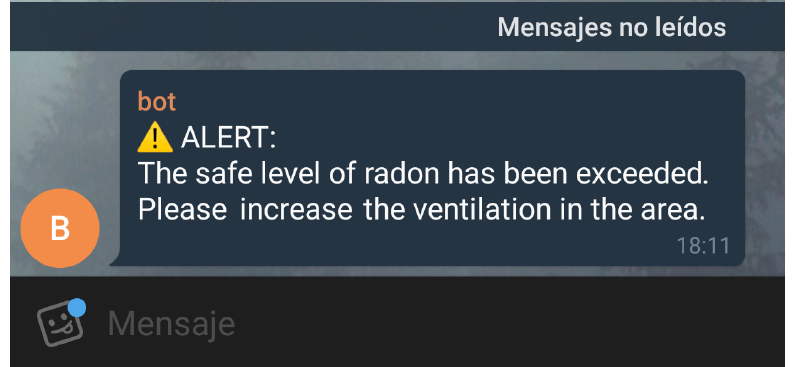
Figure 9. Telegram notification about radon gas